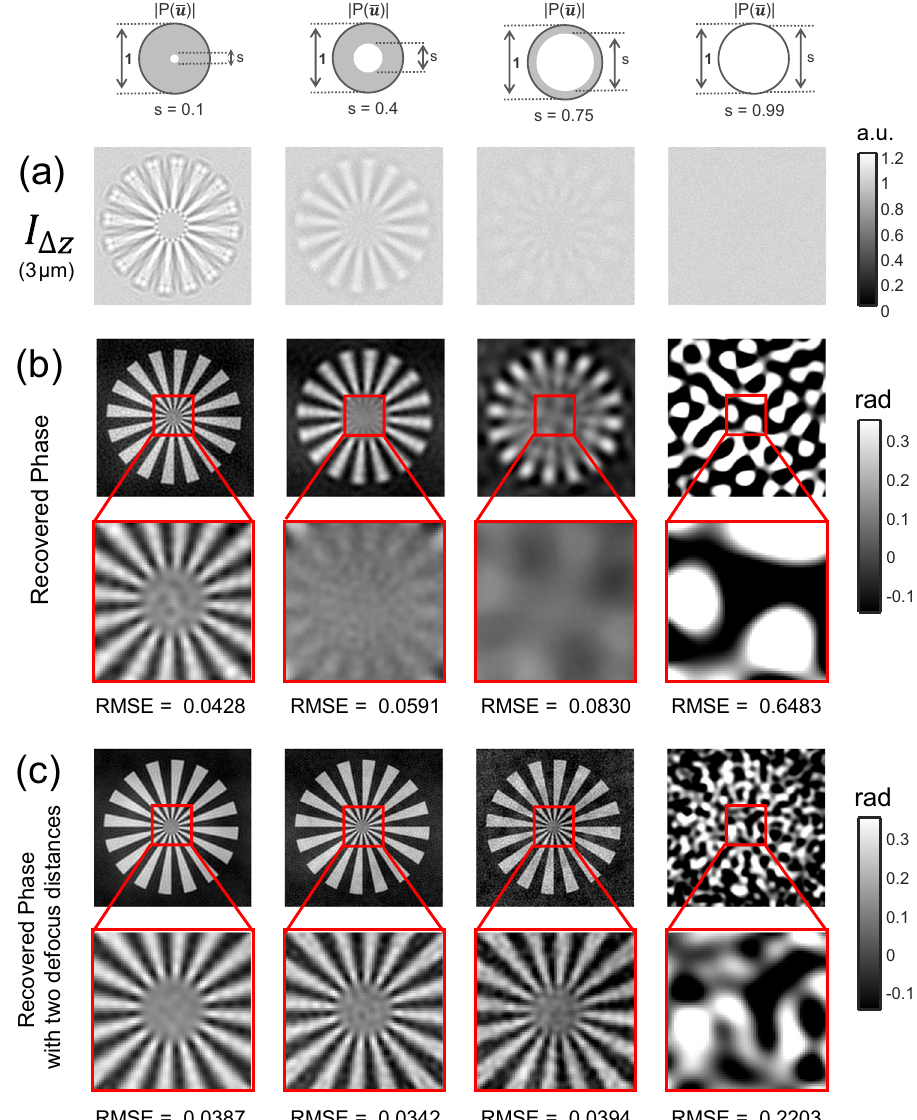
Figure 9. Comparison of over-defocus images ( a ) and reconstruction results of different illumination settings ( b ) for a large defocus distance ( Δ z = 3 μ m). The synthesized phases using both small ( Δ z = 0.5 μ m) and large defocus distances ( Δ z = 3 μ m) are shown in ( c